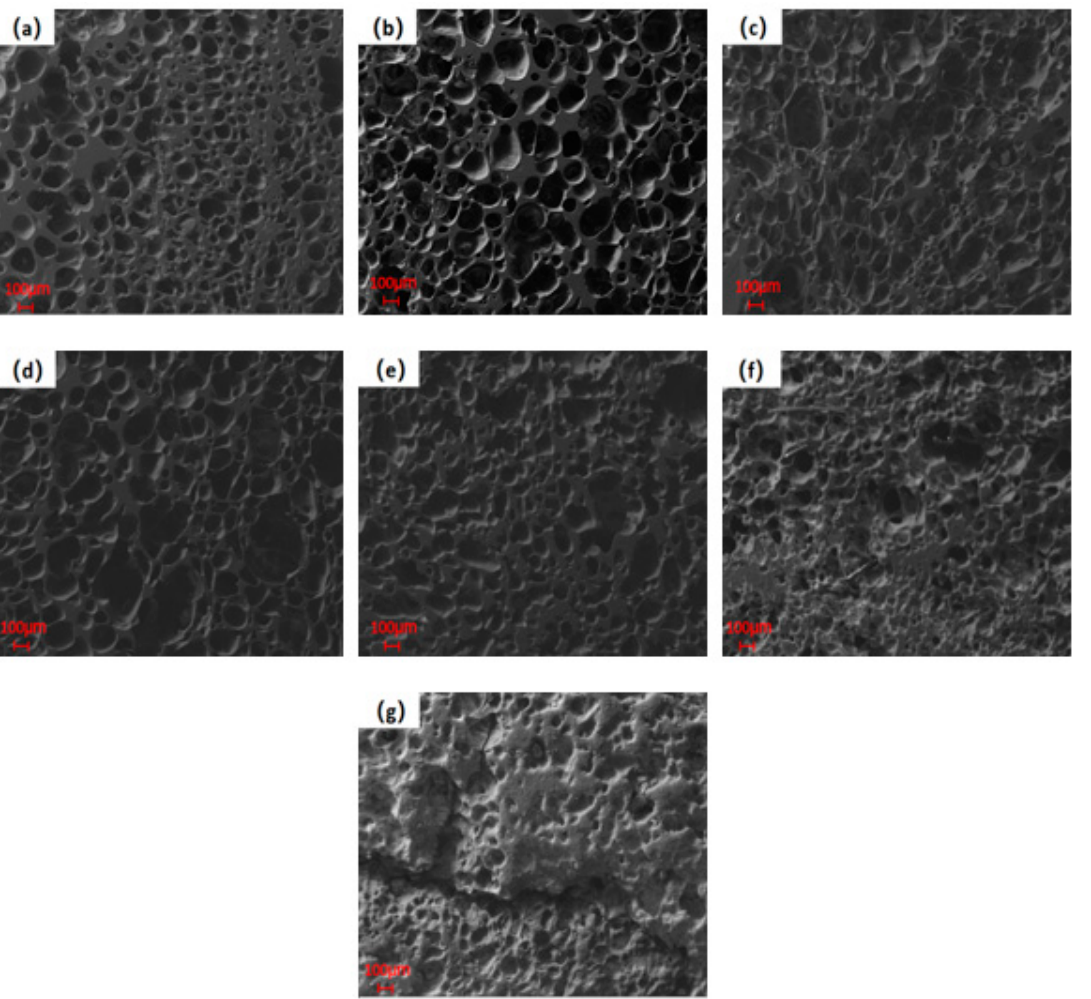
Figure 7. Scanning electron microscope (SEM) images of heated of PVC film at different temperatures: ( a ) 280 °C; ( b ) 310 °C; ( c ) 340 °C; ( d ) 370 °C; ( e ) 400 °C; ( f ) 430 °C; ( g ) 460 °C.